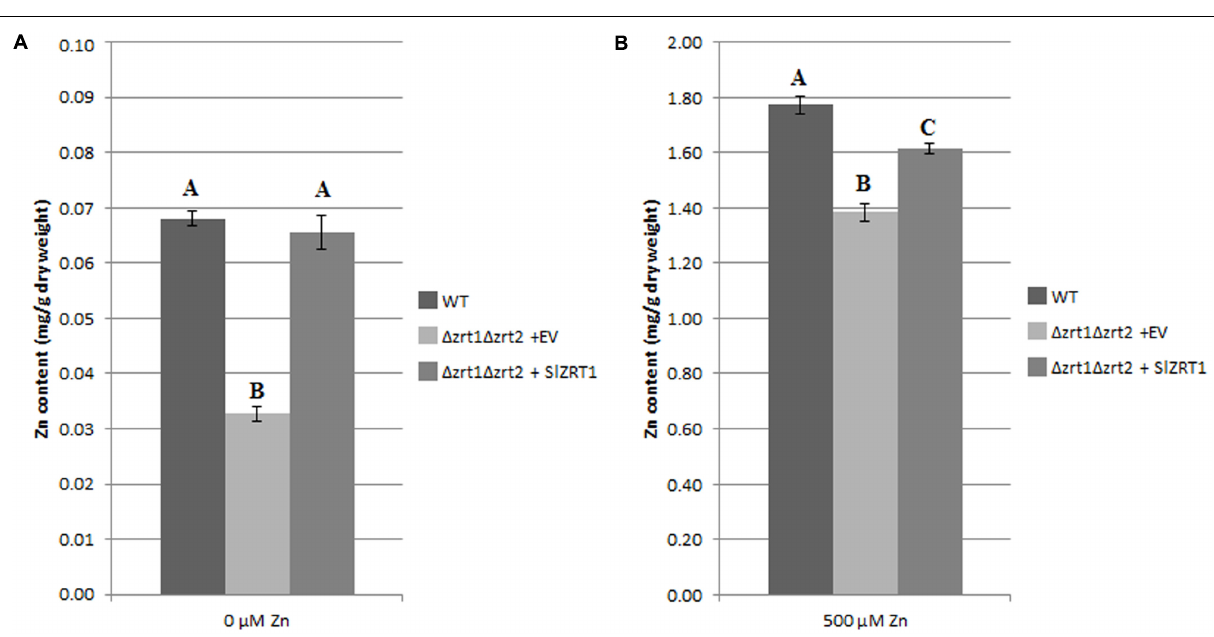
FIGURE 5 | Intracellular Zn concentrations in transformed yeast cells (A,B) . The WT strain was transformed with the EV (pYES-DEST52, Invitrogen), the mutant strain with either the EV or the vector containing SlZRT1 . Data are the average ± SE of five biological replicates, significant differences ( p < 0.05) are indicated by different letters. (A) In control conditions (0 µ m Zn), (B) after exposure to Zn (500 µ